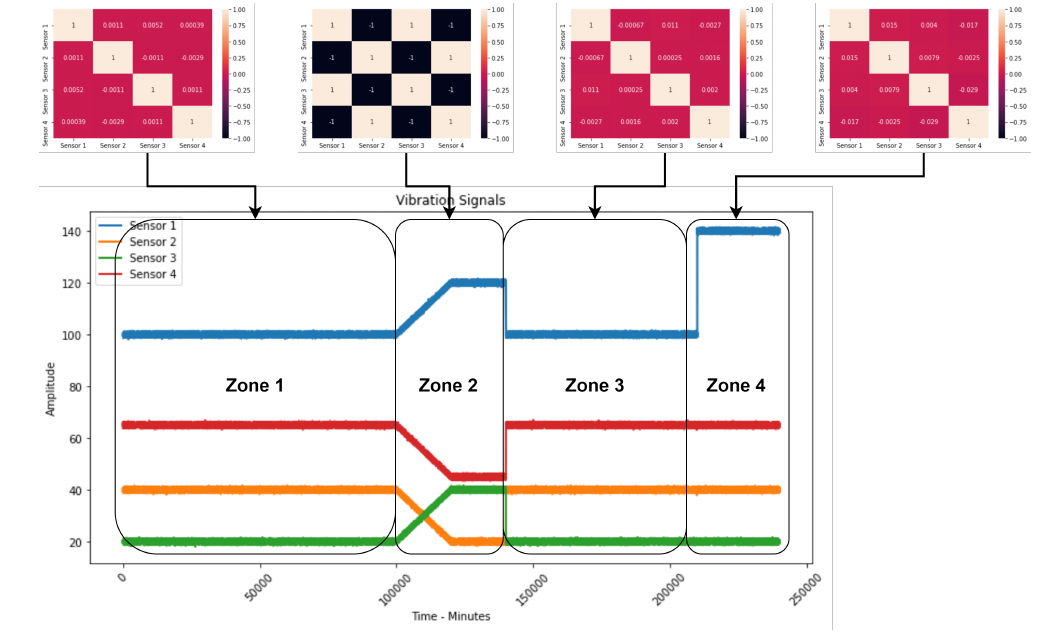
Figure 2. Correlations shown in each of the signal phases.